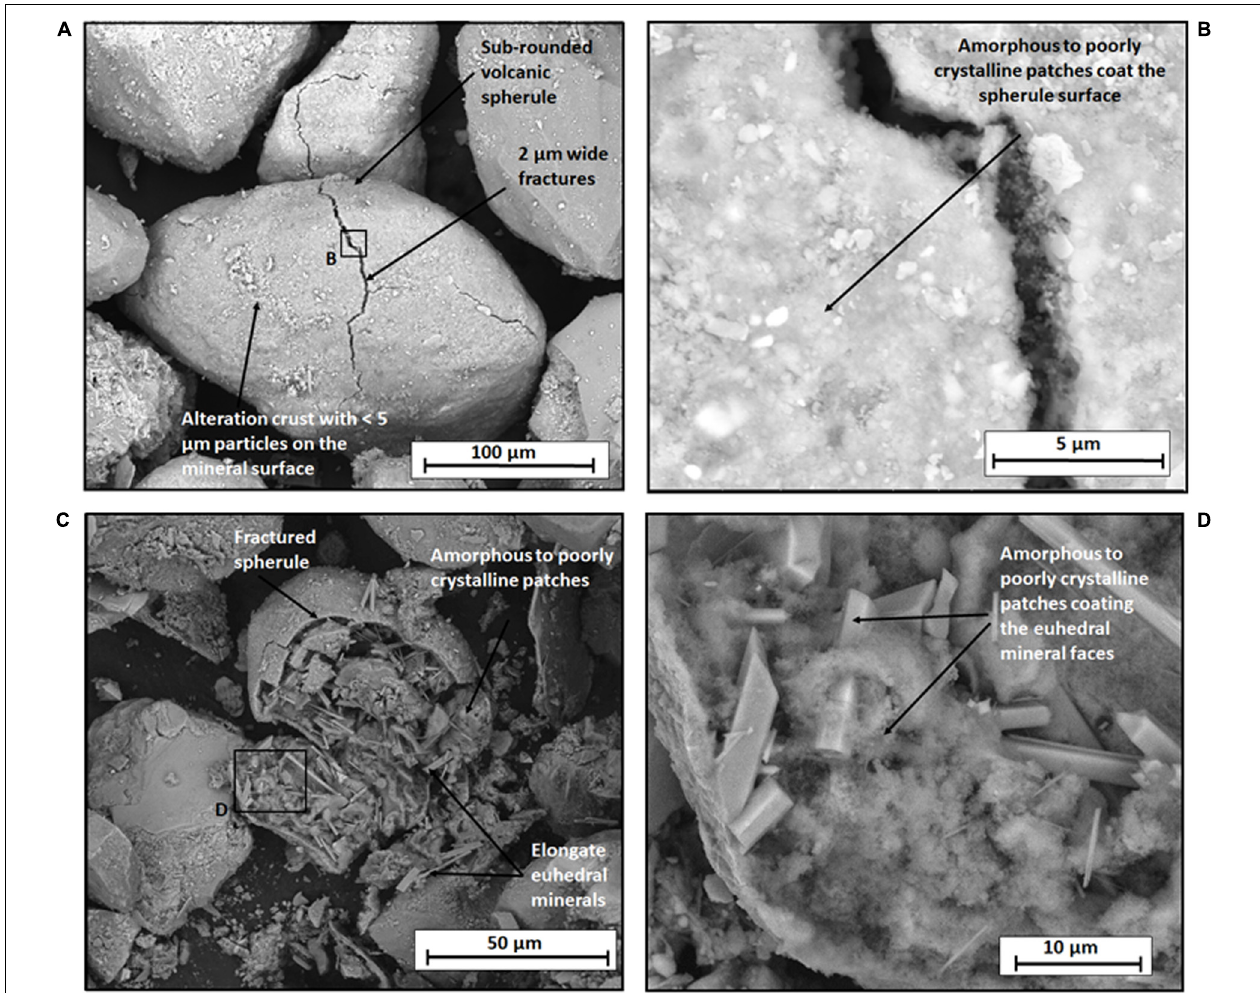
FIGURE 7 | SEM images showing the chemical alteration of volcanic ash spherules in the hyporheic zone sediments of Crescent Stream, (A) shows a ∼ 200 µ m long spherule of volcanic ash with rounded edges, fractures over the grain surface and micron-nano sized alteration crust on the grain surface; (B) shows a high resolution backscatter electron (BSE) image of the spherule surface in panel (A) showing an amorphous to poorly crystalline “sugary” texture on the spherule surface; (C) shows a ∼ 70 µ m long volcanic spherule that has chemically altered to form secondary mineral products. These products include euhedral elongate minerals and amorphous to poorly crystalline minerals; (D) shows a high resolution BSE image of the secondary mineral products in panel (C) showing that the poorly crystalline to amorphous material coats the surface of euhedral mineral